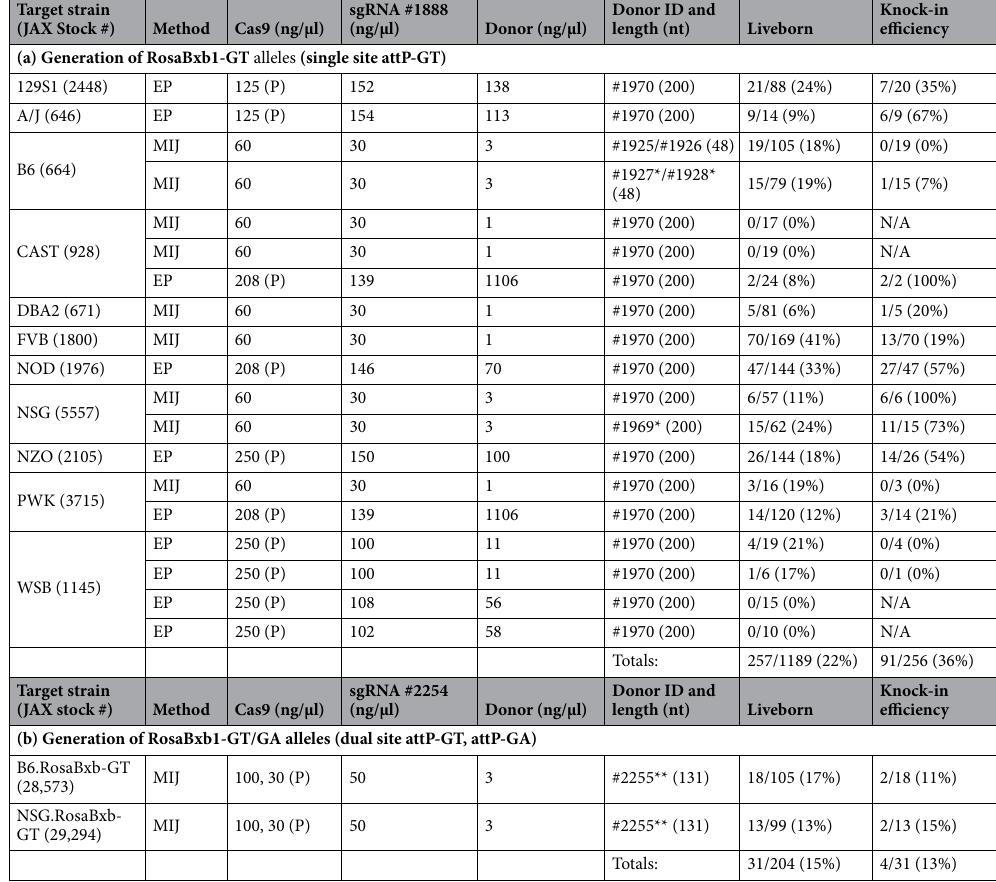
Table 1. Summary of CRISPR/Cas9-mediated Knock-In efficiency of Bxb1 attP site(s) into the ROSA26 locus. A range of CRISPR/Cas9 conditions were used to generate the RosaBxb-GT and RosaBxb-GT/GA alleles